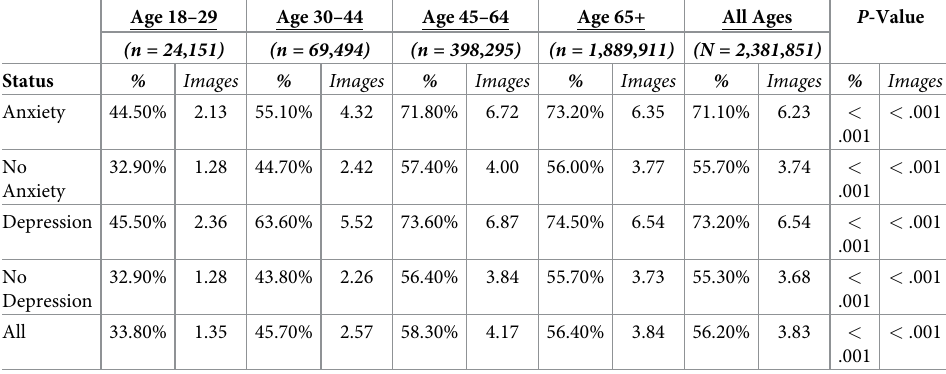
Table 4. Percentage of people receiving imaging and quantity � , by age and health status.